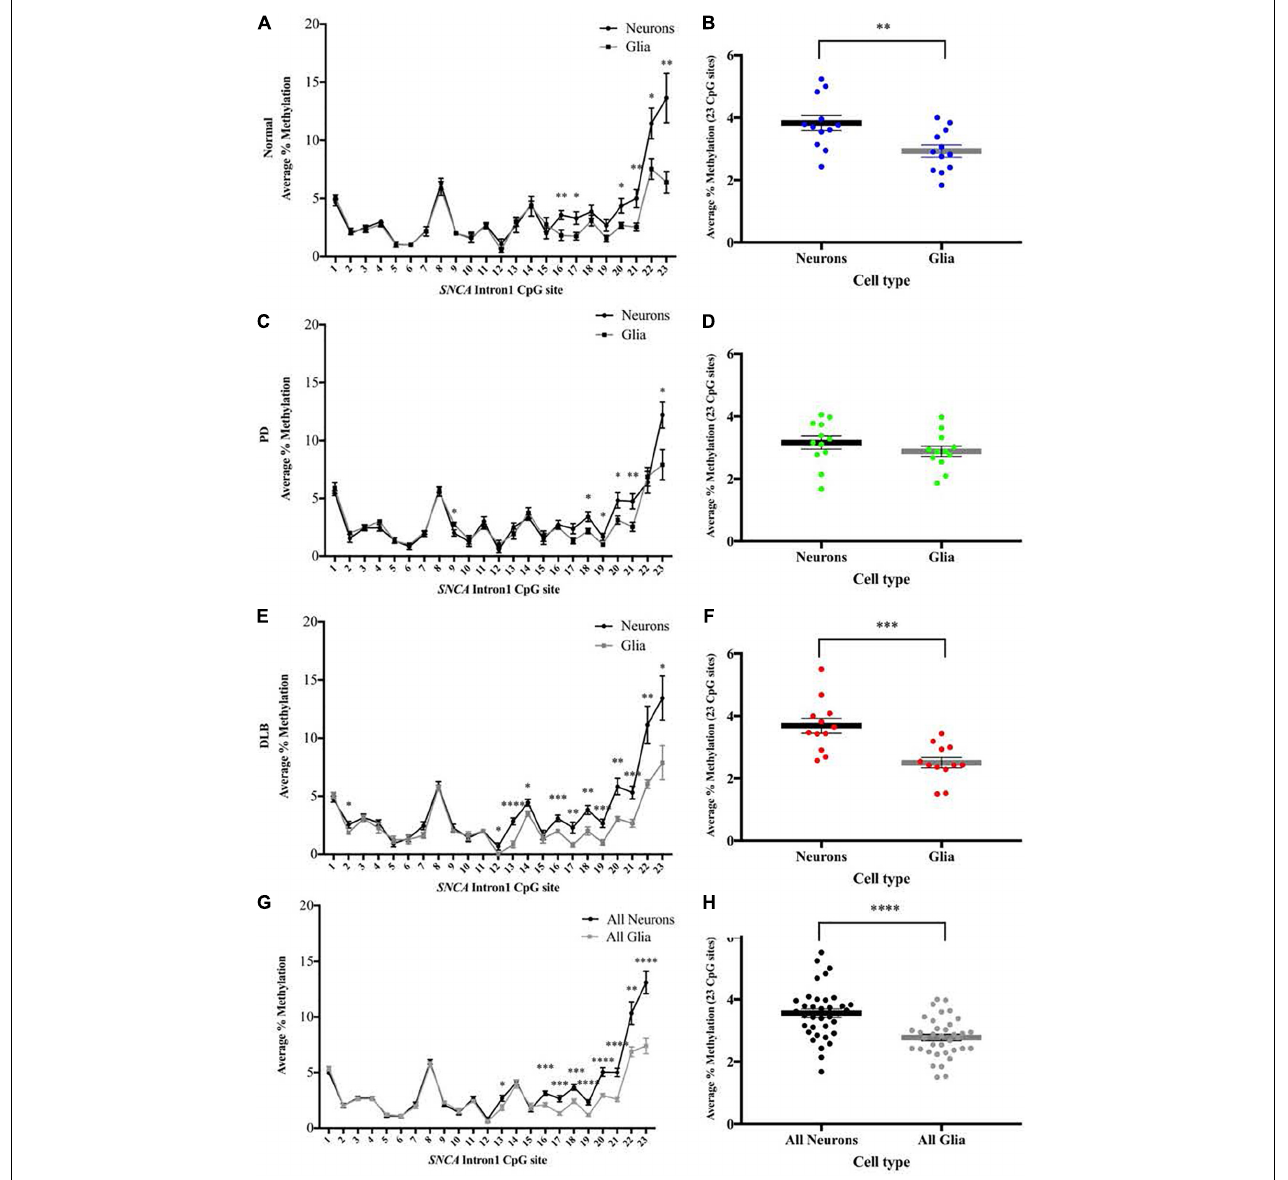
FIGURE 4 | DNA methylation profiles of the SNCA intron 1 CGI in neuron vs glia from frontal cortex tissues. DNA from each sorted nuclei sample was bisulfite converted, and the methylation (%) of the individual CpGs was quantitatively determined by pyrosequencing. Left: Graphs depict the average percentage of DNA methylation level at each of the 23 CpG sites within SNCA intron 1 CGI from (A) 12 normal, (C) 12 PD, (E) 12 DLB, and (G) all 36 subjects. Box-and-scatterplot charts display for each sorted neuronal and glia nuclei sample from each subject the DNA methylation average percentages across all 23 CpG sites within the SNCA intron 1 CGI [Chr4: 89,836,150-89,836,593 (GRCh38/hg38)] (denoted by point). The box plots also depict the mean (denoted by thick horizontal lines) and upper and lower quartiles (denoted by thin lines) of DNA methylation average percentages across all 23 CpG sites for all sorted neuronal and glia nuclei samples from (B) 12 normal, (D) 12 PD, (F) 12 DLB, and (H) all 36 subjects. The significance of the differences in % of methylation was tested using the Student’s t -test and denoted by asterisks ( ∗ ) for neuron vs glia comparisons, with ∗ p < 0.05, ∗∗ p < 0.01, ∗∗∗ p < 0.001, and ∗∗∗∗ p <